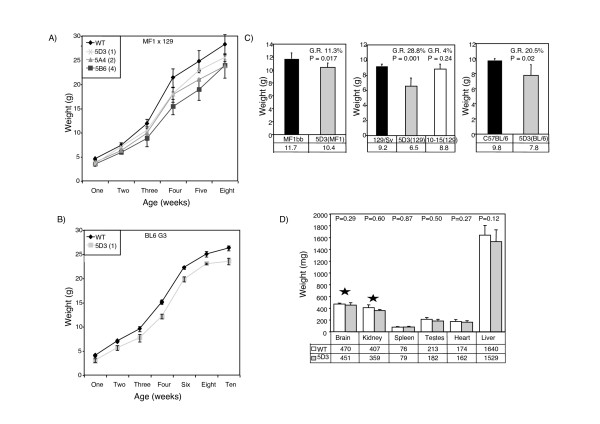
Postnatal growth retardation in mice carrying Cdkn1c transgene. A) Post natal growth curves of males from one to eight weeks for lines 5D3 (one copy, n = 2), 5A4 (two copy, n = 3) and 5B6 (four copies, n = 2) and their wild type littermates (n = 9). Mice carrying the transgene are significantly smaller in all lines (Statistical significance using Student's t-test P < 0.017 for all lines). All weights were obtained from F1 mice born from a cross between a chimaeric male founder (129/Sv) and a MF1 female. B) Post natal weight data from one to ten weeks of males for the single copy line, 5D3, bred onto the C57/BL6 background for three generation showing persistence of growth retardation after weaning (one copy, Tg n = 9, WT n = 8). C) Weights at 3 weeks of male mice from line 5D3 (one copy, Tg n = 4, WT n = 9) on a 50%:50%; 129/Sv × MF1 background labelled as 5D3/MF1) compared with a 75%:25% background labelled as 5D3/129 (Tg n = 6, WT n = 8). Interaction with a genetic factor within the 129/Sv background results in a more severe growth retardation, increasing from 11.3% to 28.8% (Statistically significant change using Student's t-test. P = 0.014). On a C57BL/6 background, the growth retardation is intermediate at 20.5% (Tg n = 9, WT n = 8). No significant growth retardation is observed in transgenic line 10–15 on a 129/Sv background (Tg n = 8, WT n = 4, P = 0.24). This line carries three copies of the modified BAC where transgenic Cdkn1c is not functional demonstrating that growth retardation is likely due to excess Cdkn1c. C) Comparison of organ weights in wild type and 5D3 transgenic adult males at 8–10 weeks. Growth retardation is not restricted to organs in which there was excess embryonic Cdkn1c WT n = 9 and Tg n = 6). *denotes tissues that were exposed to excess Cdkn1c during embryogenesis.